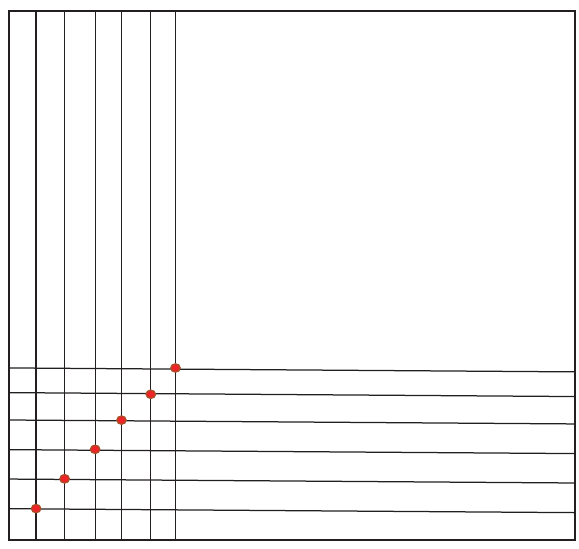
Figure 7: Interaction effect of chloride diffusion from 2